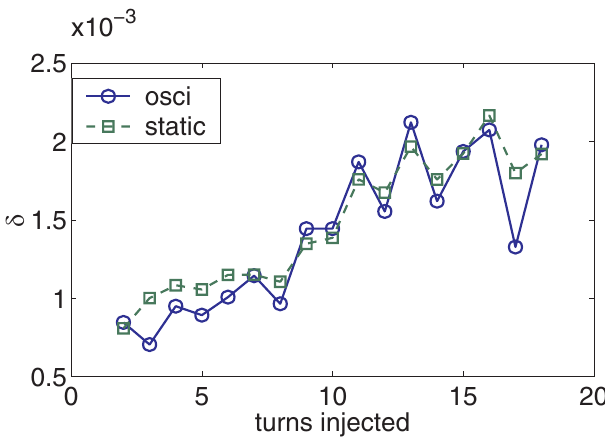
FIG. 25. (Color) The average rms momentum width (cid:5) ( (cid:4) (cid:5) in the text) obtained with two methods: Eq. (23) (‘‘static’’) or Eq. (21) (osci).